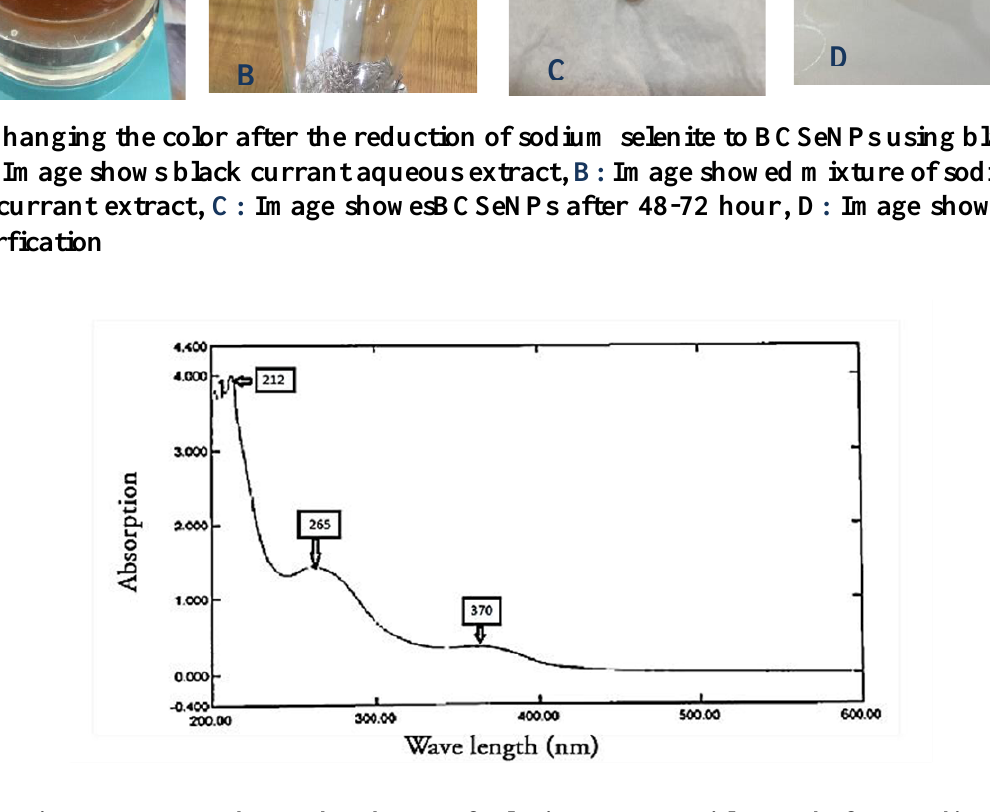
Figure 2. UV-Vis spectroscopy shows absorbance of selenium nanoparticles made from sodium selenite with black currant extract in PH 9